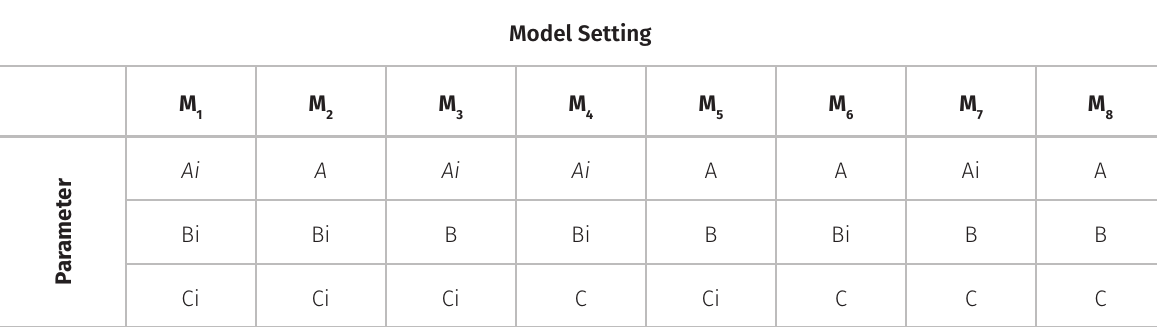
Table I. Description of the tested models for the growth curve of tambaqui ( Colossoma macropomum ). Model